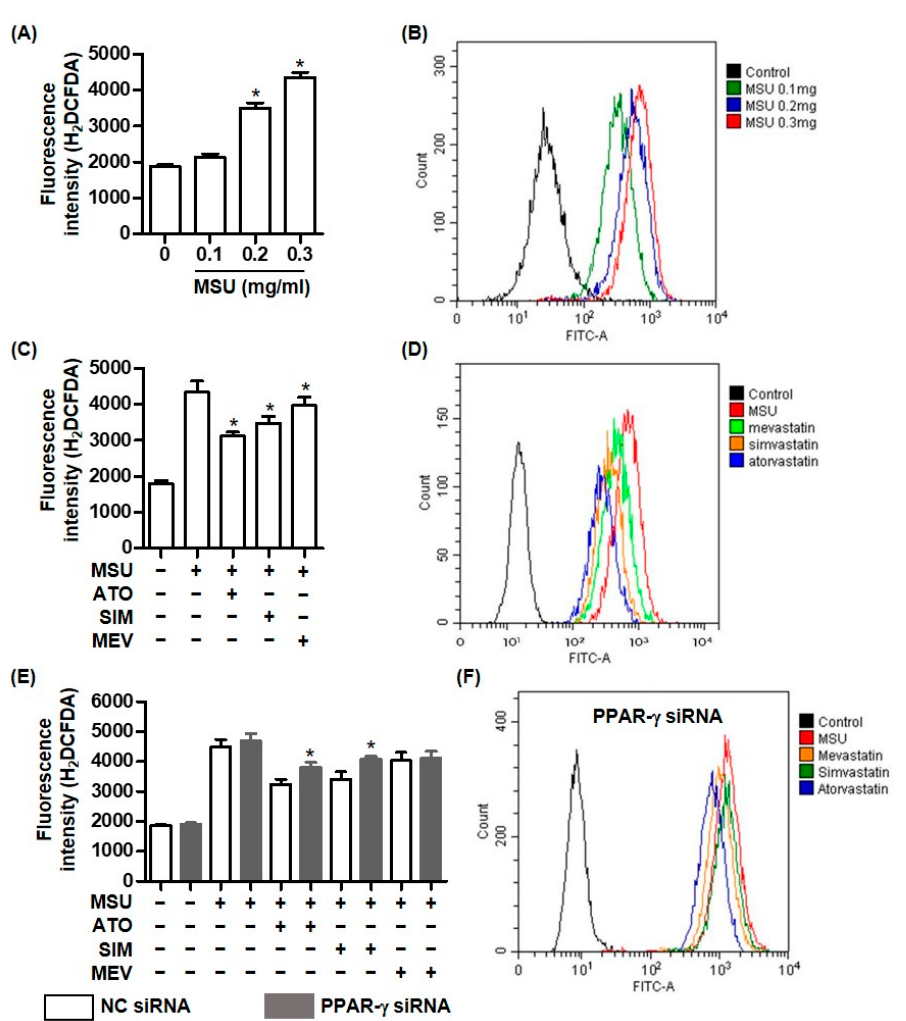
Figure 4. PPAR- γ is required for the inhibitory effect of statins on intracellular ROS generation in MSU crystal-mediated inflammation. ( A , B ) Intracellular ROS generation is measured in THP-1 cells treated with MSU crystals (0.1, 0.2, and 0.3 mg/mL) for 24 h using H 2 DCFDA or flow cytometry analysis. ( C , D ) Intracellular ROS generation by MSU crystals (0.3 mg/mL) for 24 h measured in THP-1 cells pretreated with statins using H 2 DCFDA or flow cytometry analysis. ( E ) Intracellular ROS generation under stimulation with MSU crystals (0.3 mg/mL) measured in THP-1 cells transfected with and without PPAR- γ siRNA and pretreatment with statins using H 2 DCFDA. ( F ) Intracellular ROS generation under stimulation with MSU crystals (0.3 mg/mL) measured in THP-1 cells trans- fected with PPAR- γ siRNA and pretreatment with statins using flow cytometry analysis. * p < 0.05, compared to cells treated without MSU crystals ( A ), cells treated with only MSU crystals ( C ), and cells transfected with NC siRNA ( E ) using Kruskal–Wallis test followed by Dunn’s multiple com- parison test. **: p < 0.01; #: p < 0.05. Values presented as mean ± SEM of three independent experi- ments. The images are representative of three independent experiments. Abbreviations: MSU, mon- osodium urate; ATO, atorvastatin; SIM, simvastatin; and MEV, mevastatin.